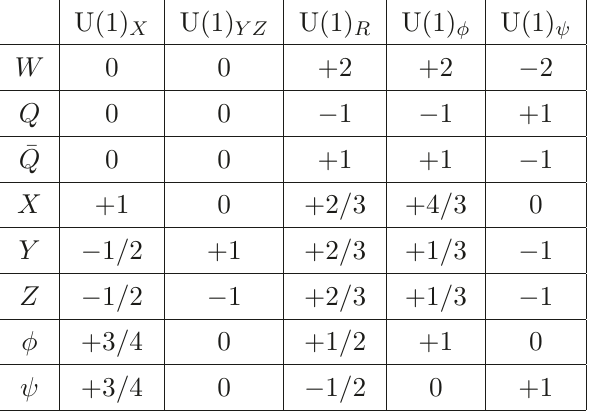
Table 1 . R and non- R global charges. The charge assignments in the effective theory are J φ = 2 J X + J R and J ψ = 2 J X J R . The U(1) Y Z symmetry acts trivially on all light states on the X 3 3 − branch. The fermion-number symmetry U(1) ψ is unbroken even when φ gets an expectation value, and organizes Feynman rules in large- J